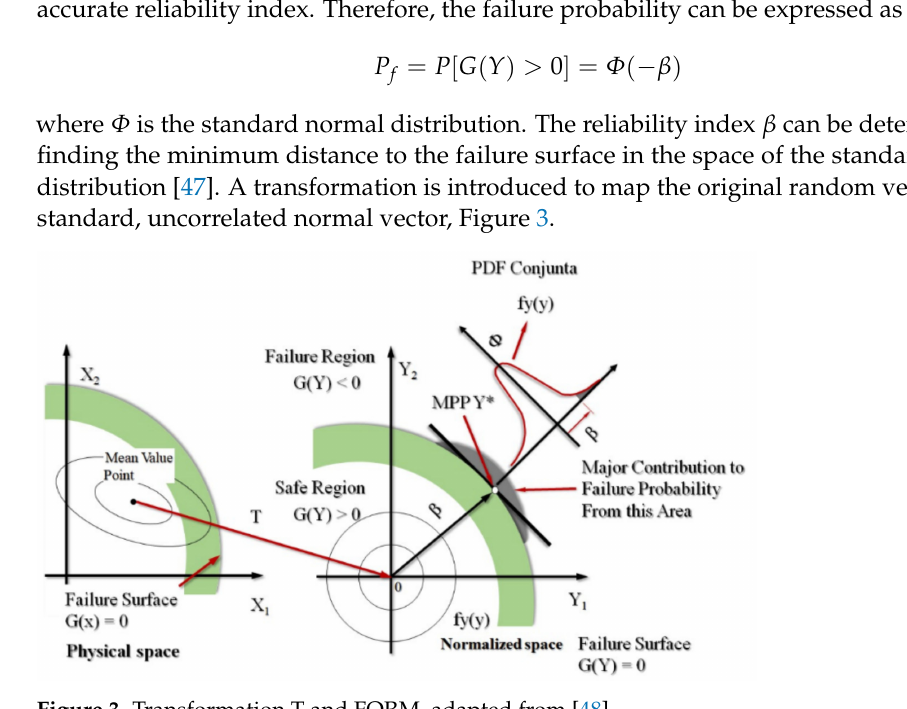
Figure 3. Transformation T and FORM, adapted from